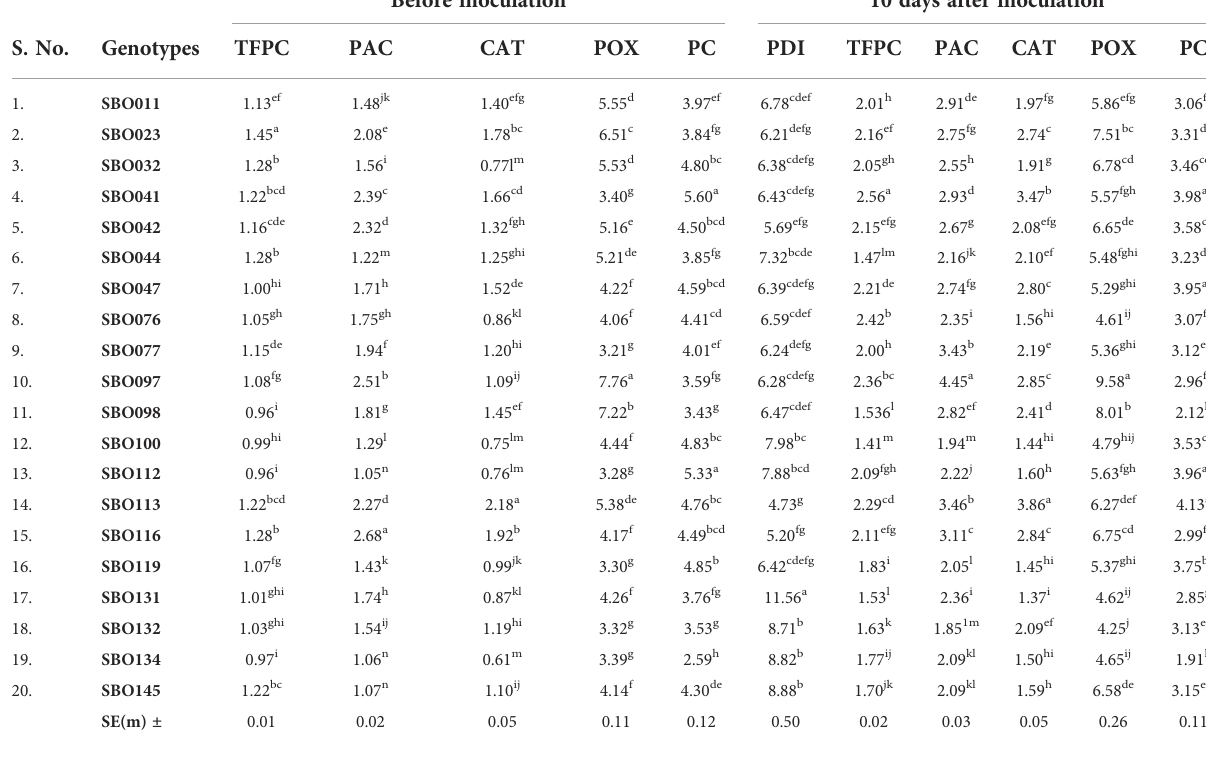
TABLE 5 Mean activity of biochemical compounds, before inoculation and after inoculation, at different day intervals. Before inoculation 10 days after inoculation S.